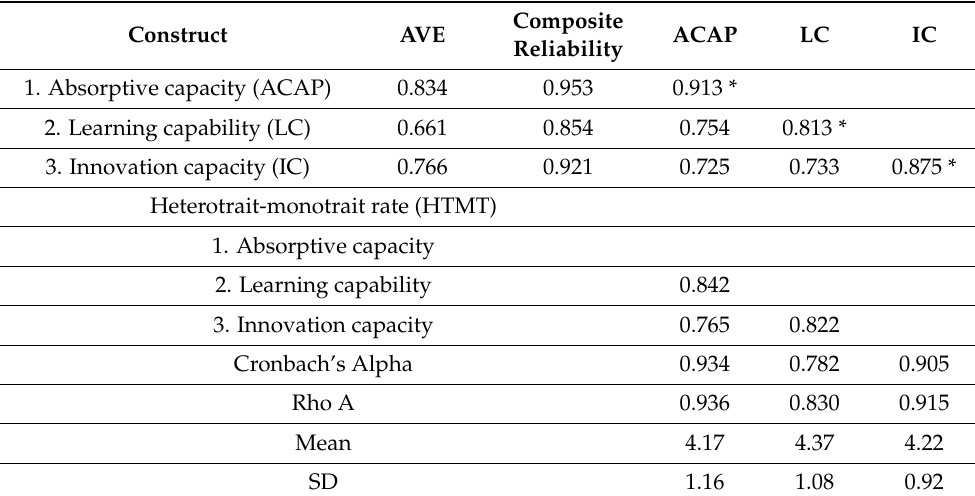
Table 3. Correlation matrix, composite reliability, convergent, and discriminant validity, Heterotrait- monotrait ratio (HTMT) and descriptive statistics.